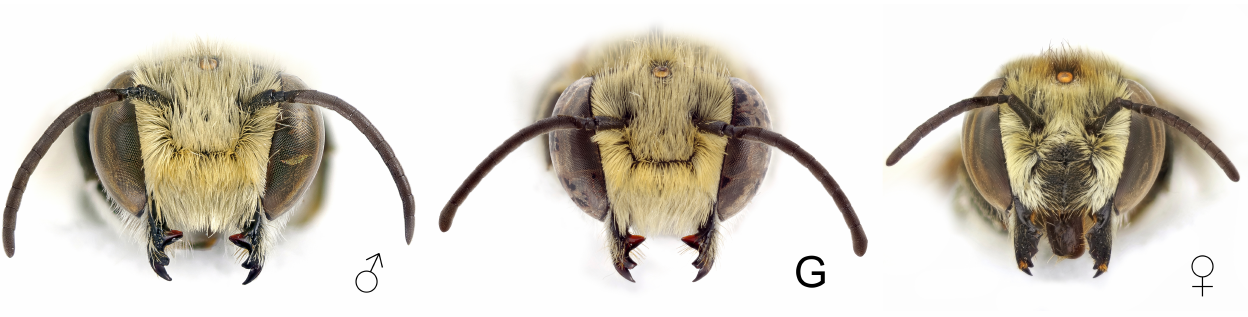
Figure 3. Head of Megachile pilidens , frontal view: , male; G, gynandromorph; , female. ♀ ♂ Length of antennal segments : Flagellomeres distinctly longer than wide (Figure 3). Face pubescence : Dense hairs on the whole face, including clypeus (Figure 3). Mandibles : Three large teeth, the proximal one very large, plus an additional ventral tooth (absent in females) (Figure 3). Front femora : Larger than in females; ventral apical margin enlarged and yellow (completely black in females) (Figure